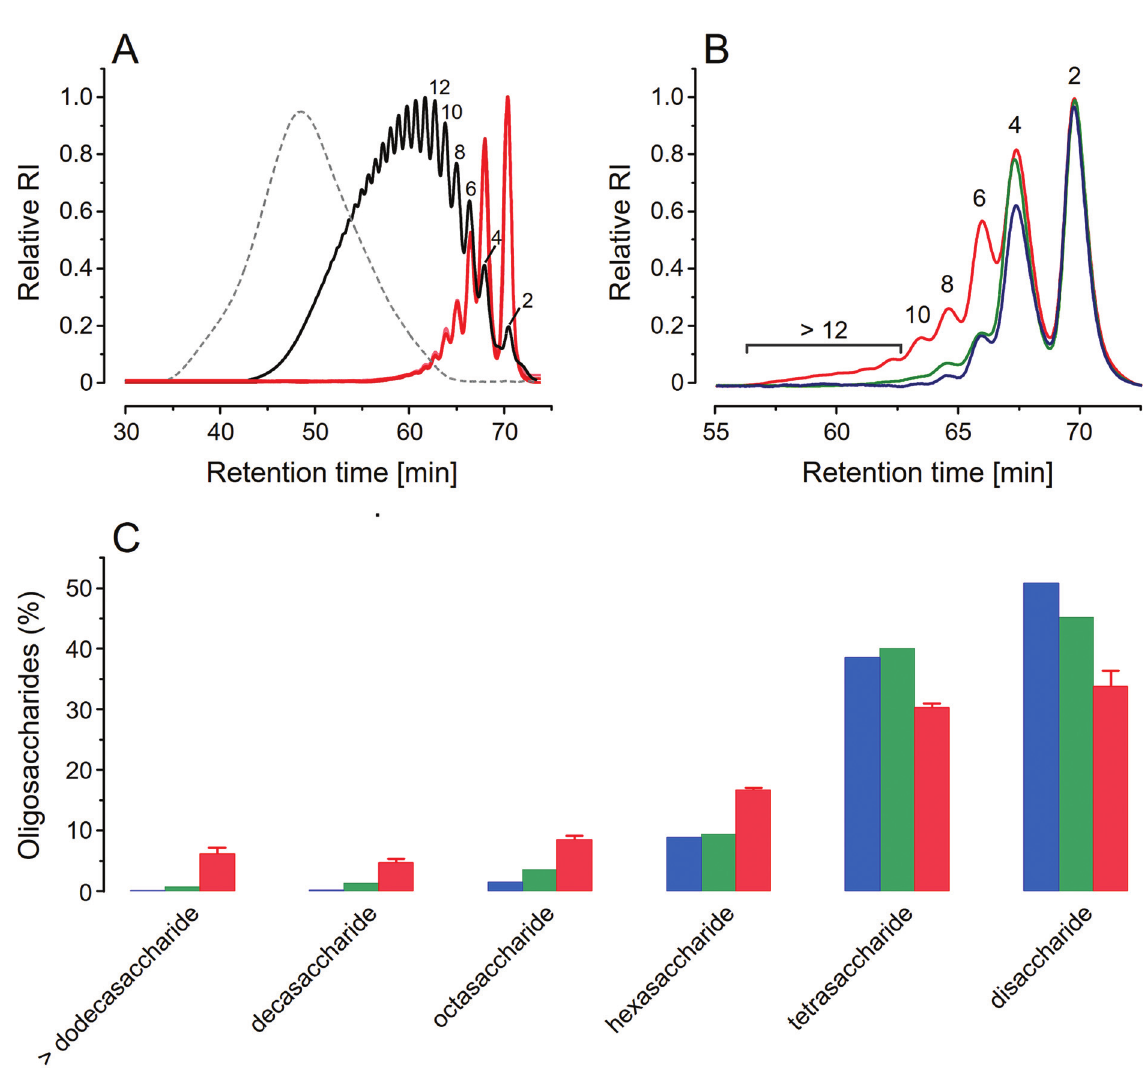
Fig. 6 Heparins from different sources generate particular fragmentation maps. (A) Size-exclusion chromatograms of the oligosaccharides formed by digestion of three batches of HPI (red lines) with heparinase I; non-digested HPI (dashed gray line) and the 3 th International Standard for LMWH (solid black line), numbers in the panels indicate the degree of depolymerization of the oligosaccharides. (B) Chromatograms of the oligosaccharides formed by digestion of HOI, HBL and HPI (in blue, green and red, respectively, in all panels) with heparinase I. (C) Proportions of the oligosaccharides produced by each heparin